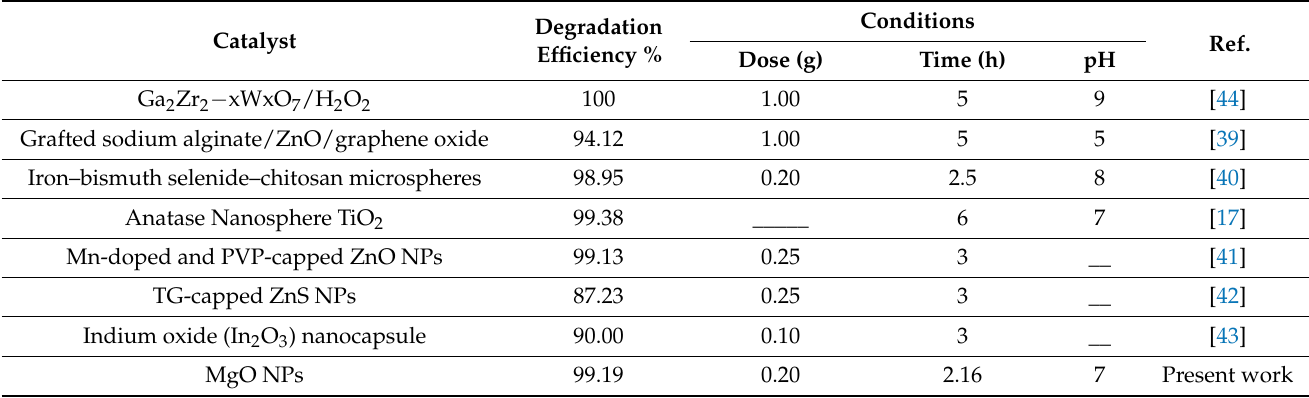
Table 5. The photocatalytic degradation of crystal violet by different catalysts.